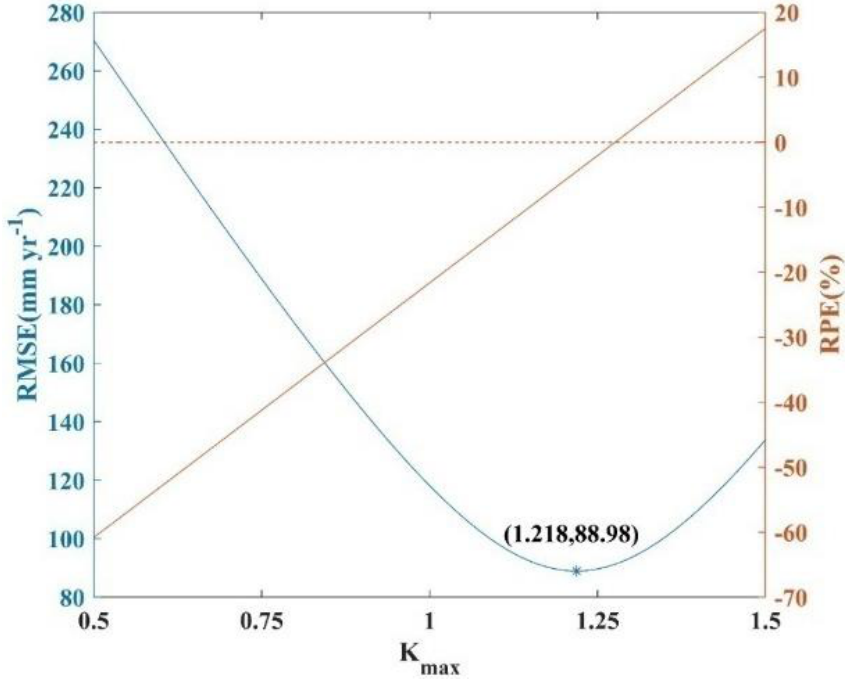
Figure 10. RMSE and RPE di ff erences between WB-ET and ET SSEBopYRB for di ff erent k max settings. The WB-ET was derived from the fourteen catchments reported in Figure 1.